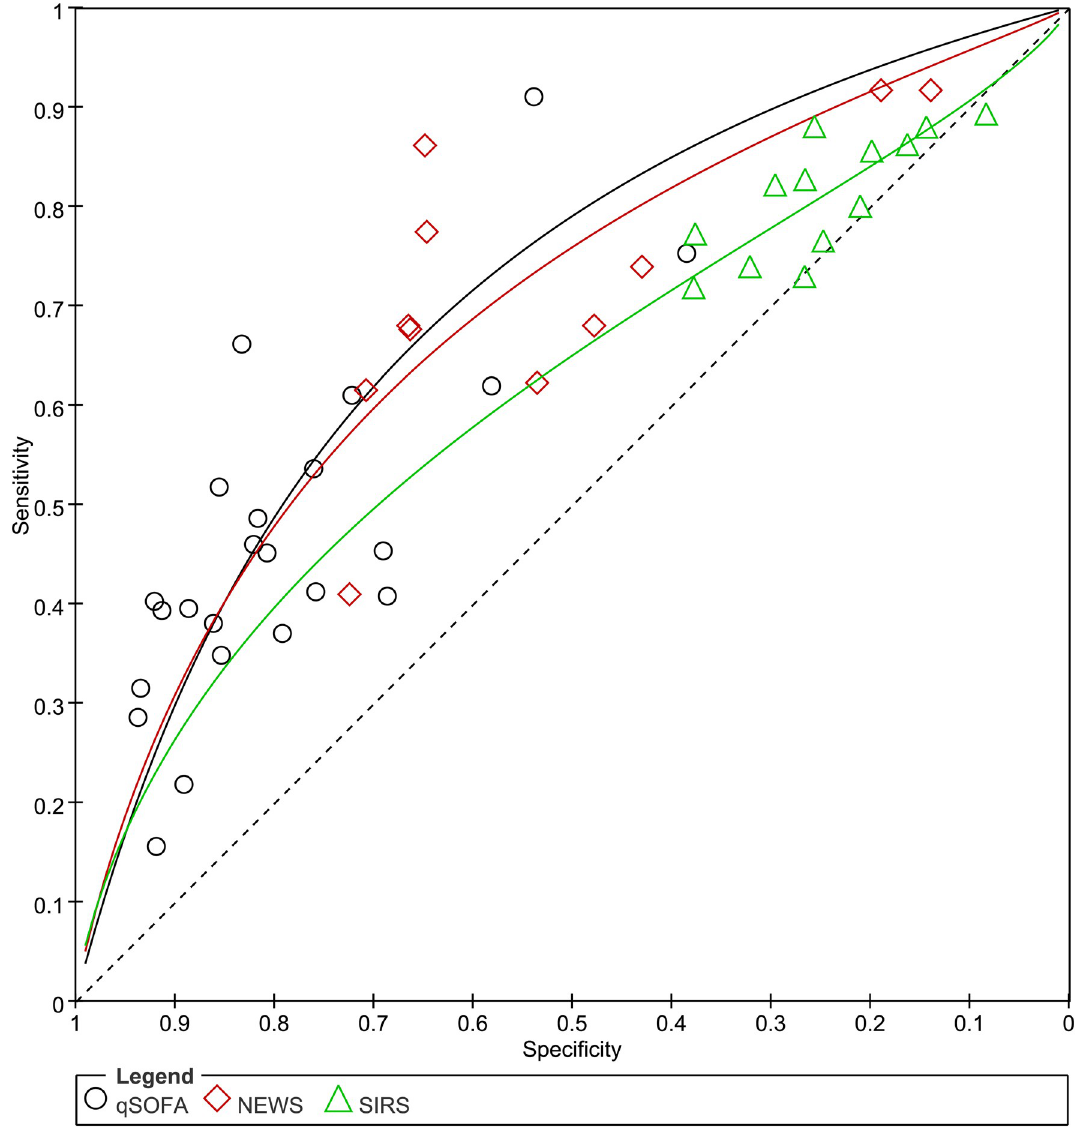
Fig 5. Direct comparison among qSOFA, SIRS, and NEWS in predicting the accuracy of mortality in patients with suspected sepsis.